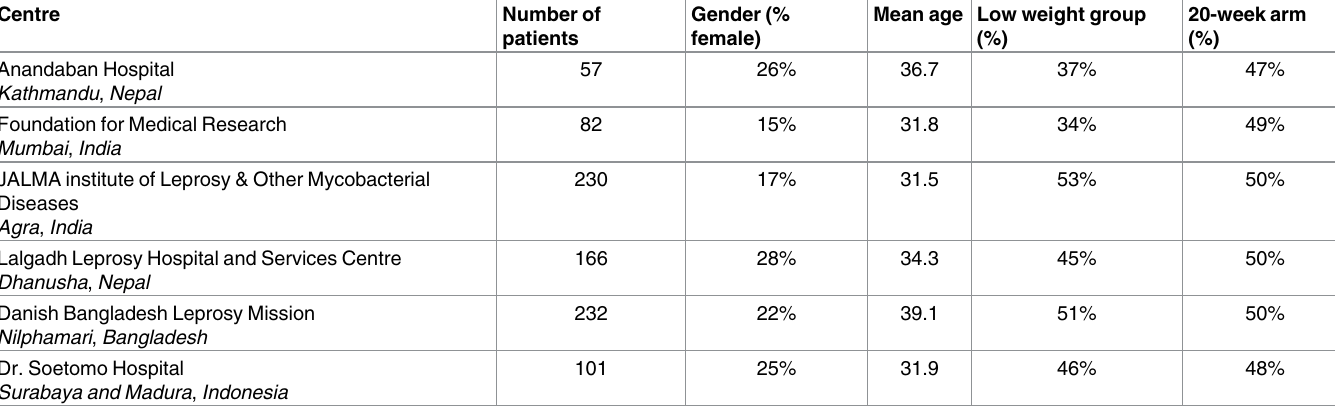
Table 2. Intake per